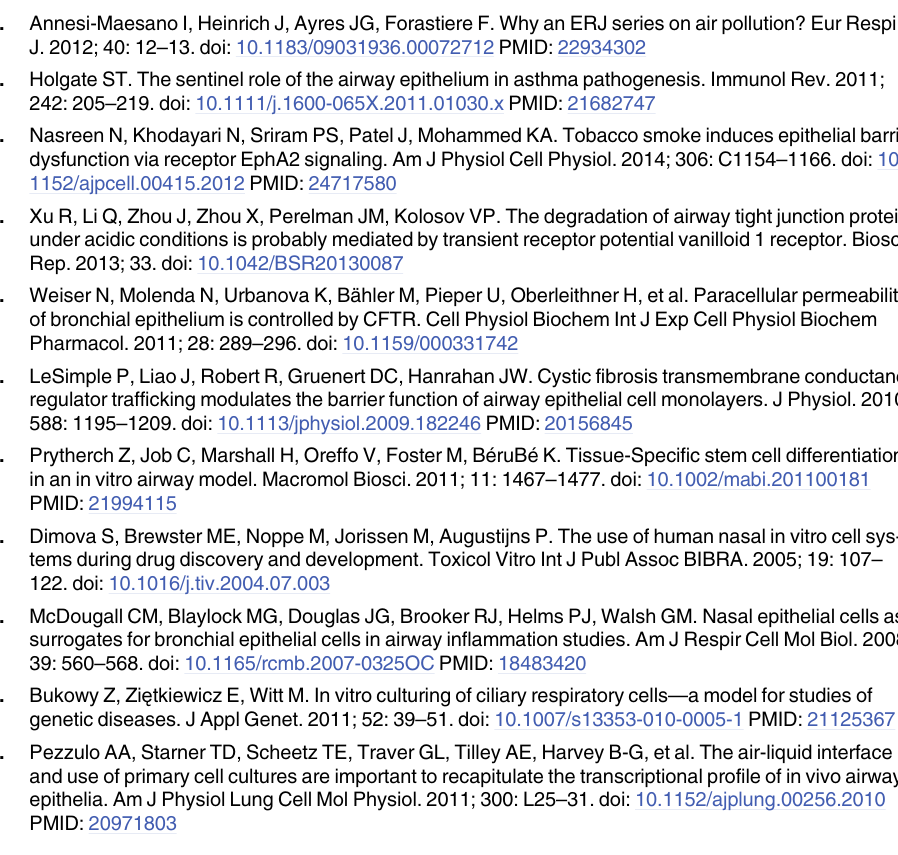
Table D. Regression and statistical analysis of Fig 8. Table E. Mean TER values for Drug regime I. Table F. Mean TER values for Drug regime II. Supporting Information